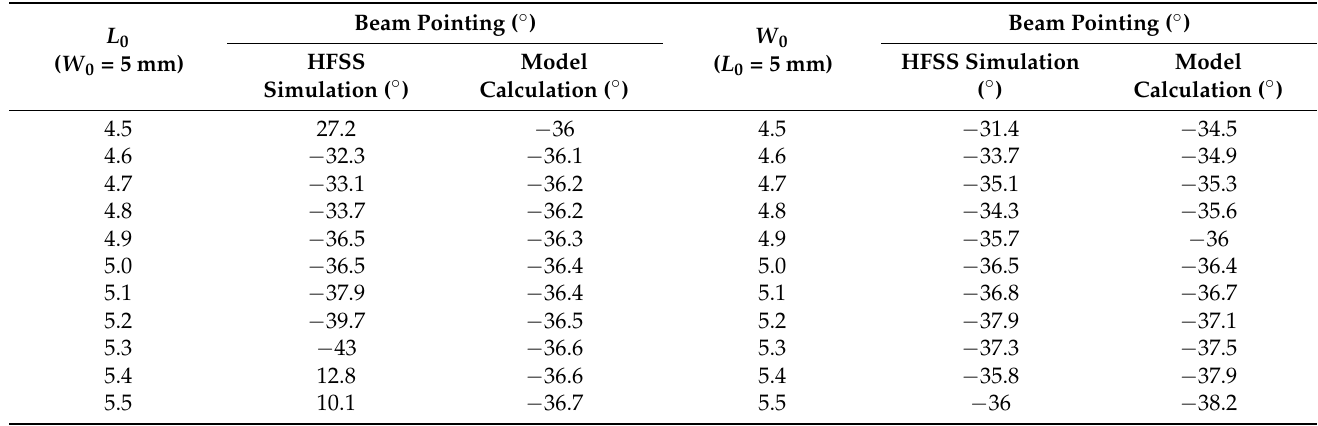
Table 11. HFSS simulation results and coupling model calculation results of different W 0 and L 0 parameters under Mode 4 antenna.